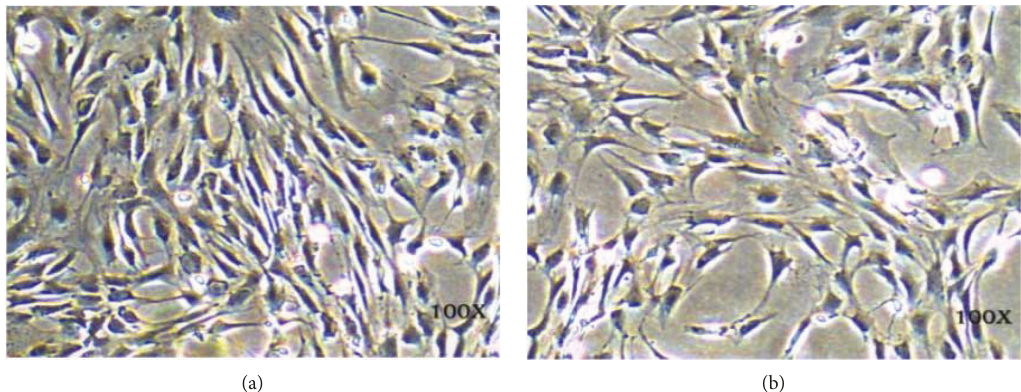
Figure 1: Light microscopy images of ASCs. (a, b) Two di ff erent fi elds of cultured ASCs. Magni fi cation, ×